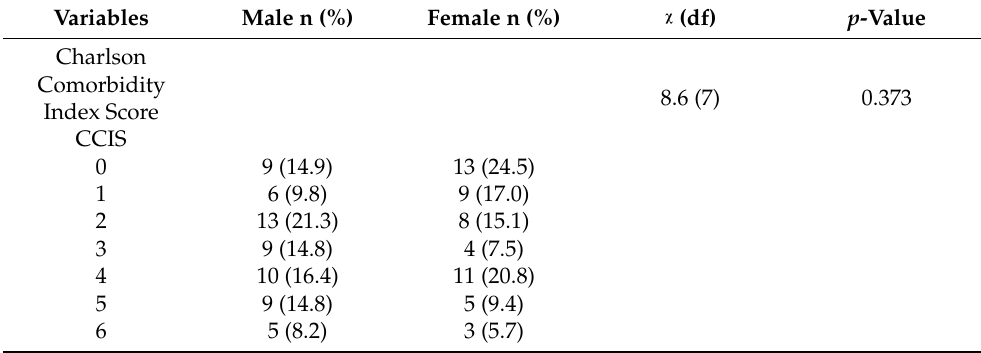
Table 6. Patients’ Charlson Comorbidity Index Score CCIS measurement (N = 114).